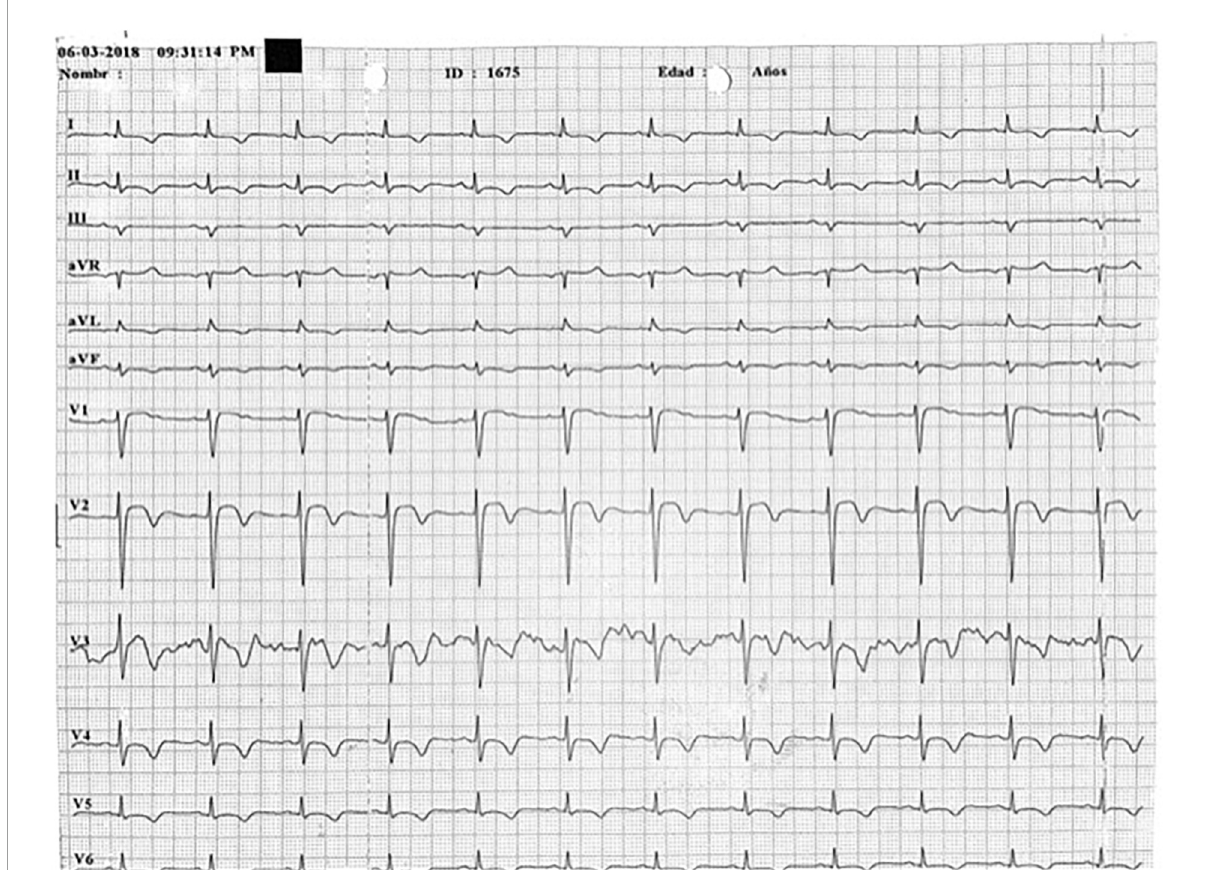
FIGURE3 Electrocardiogram series. Shows electrocardiogram at day 7 since TTS diagnosis: A Wellens Pattern (type 1) is now observed in V2 and V3 leads t wave inversions and prolonged QT interval remains.